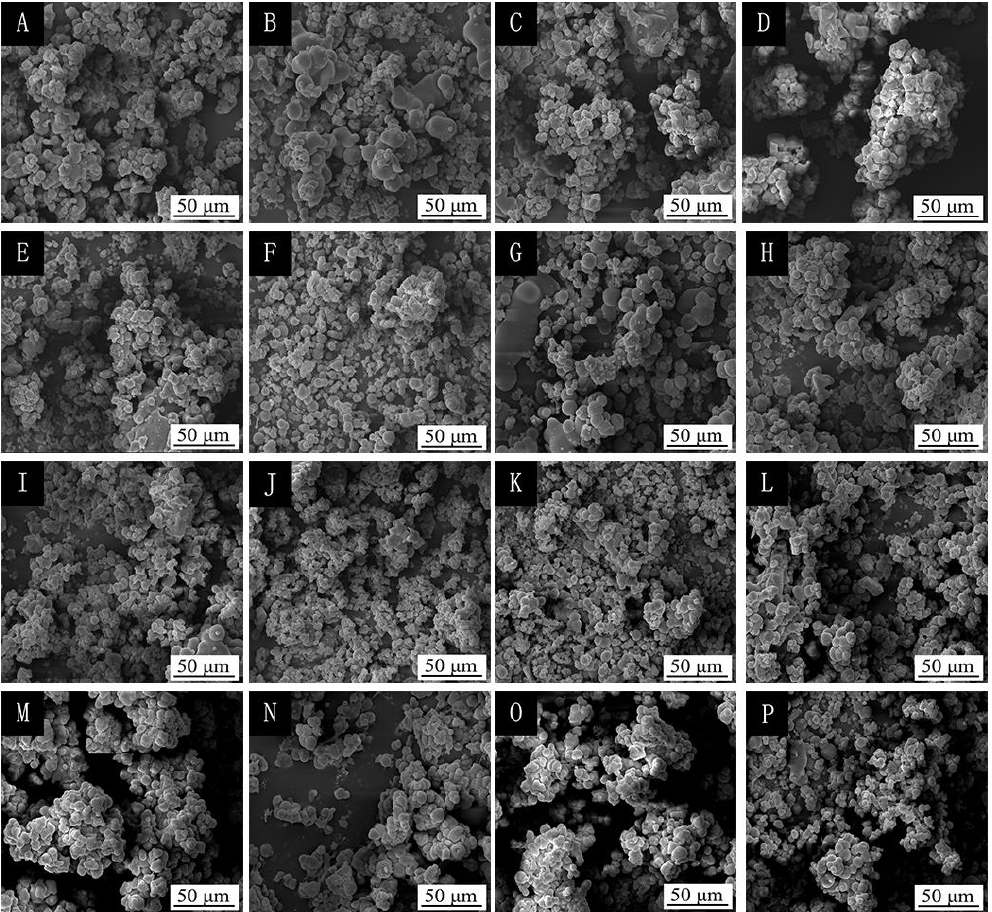
Figure 2. Scanning electron microscope (SEM) images of microcapsules obtained from the orthogonal test: ( A – P ) correspond to Samples 1–16 in the orthogonal test of Table 2.